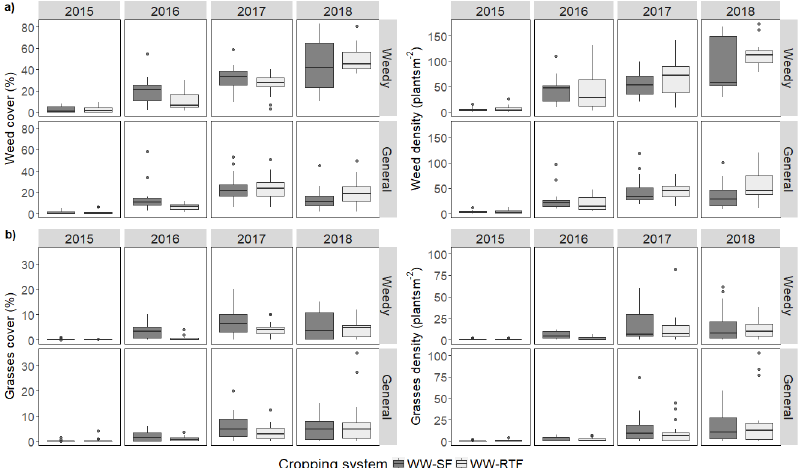
Fig 2. Total weed density and cover (a) and grass weed density and cover (b) observed in the weedy and general areas in the cropping systems (Winter wheat (WW)–Summer Fallow (SF) and WW–Reduced Tillage Fallow (RTF)) along the study